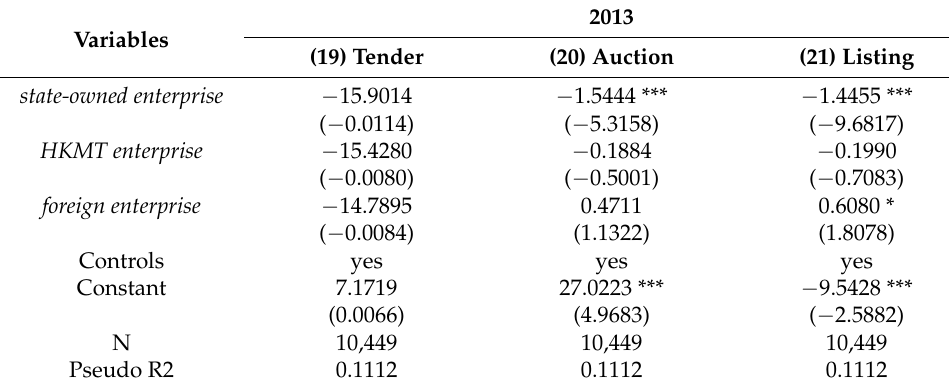
Table A3. Results of mlogit model considering types of enterprises